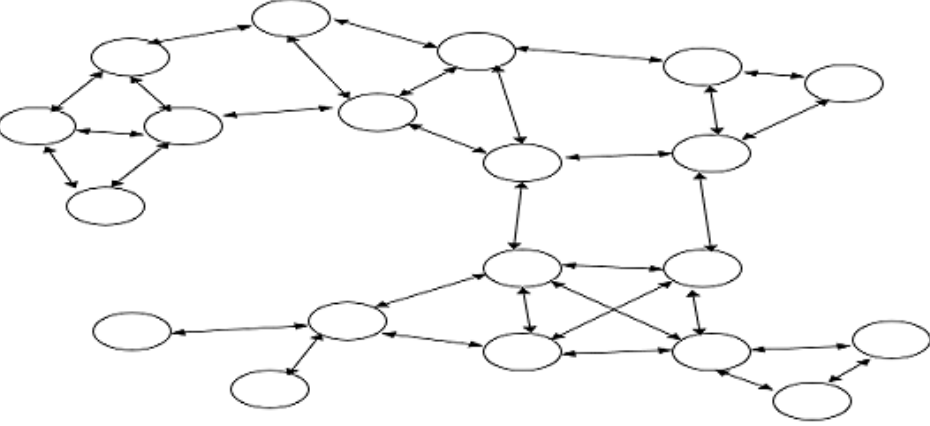
Figure 3. Non-hierarchical Bidirectional network with 20 sensor